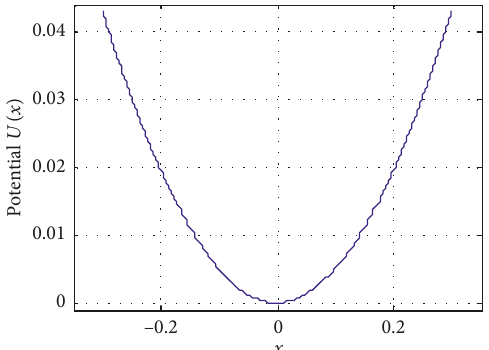
Figure 12: Potential function of the unperturbed system.